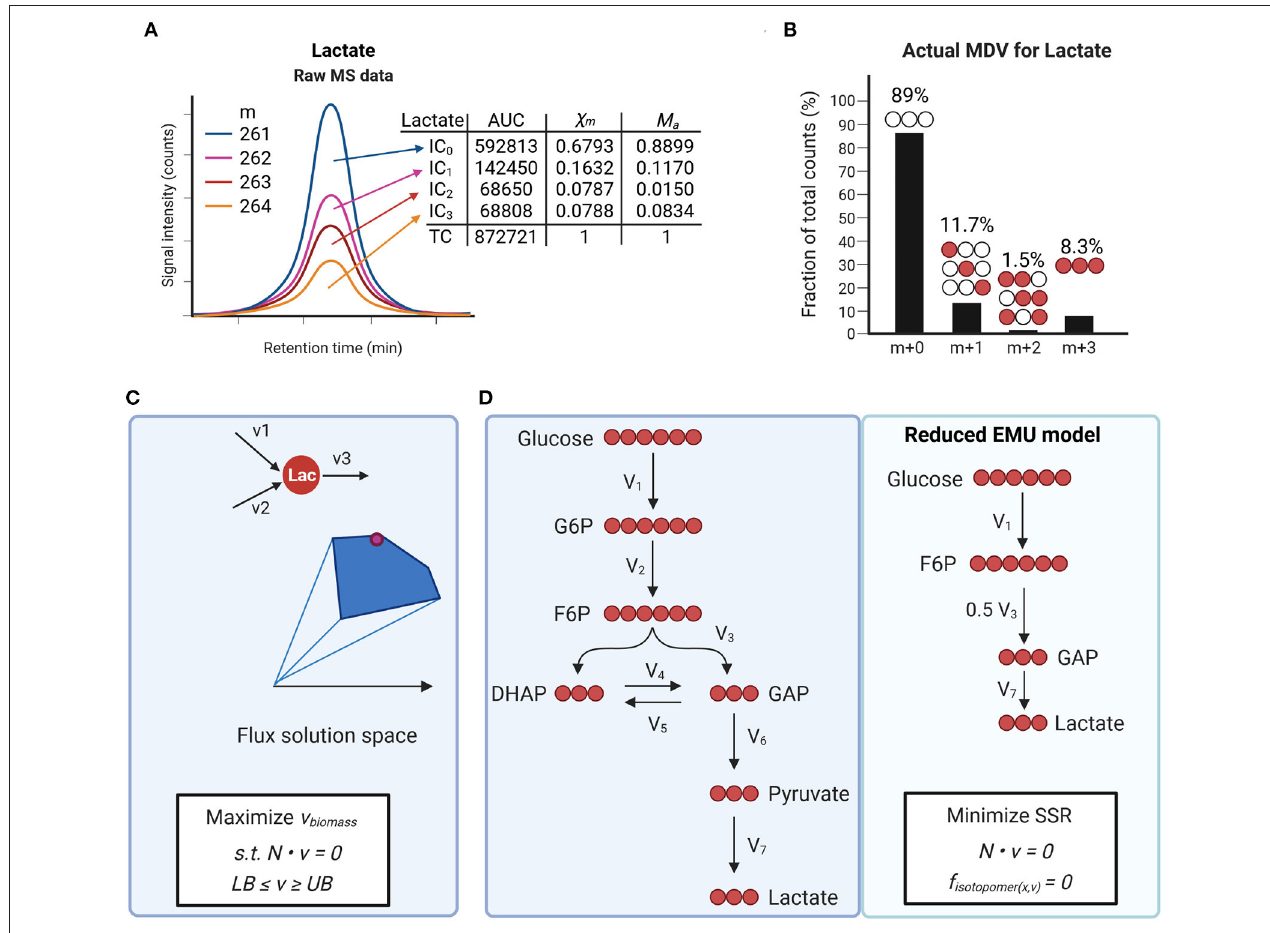
FIGURE 3 | Isotope tracing to measure metabolic fluxes. (A,B) Example of isotopomer distribution analysis using mass spectrometry (MS) for 13 C-lactate. Ion counts for different isotopologues (IC) are determined by measuring the area under the curve (AUC). Mass distribution vectors (MDVs) for lactate (X m ) are determined by dividing each IC by the total counts (TC). Measured MDVs are then corrected for naturally occurring isotopes (B) . Actual MDVs for lactate can now be used for further data analysis such as metabolic flux analysis. (C) Flux balance analysis allows estimating flux distributions at steady state. Optimization functions are defined based on biological questions and applied to a network. Constraints for each flux vector are defined as lower bonds (LB) and upper bonds (UB) which allow to define flux solution spaces. (D) Schematic of carbon atom distribution in a simplified model of glycolysis using [U- 13 C]-glucose infusion. Network reactions can be further reduced to a define a final reduced EMU model. Flux distributions are estimated by minimizing the sum of least-squared residuals (SSR) between the measured rates and model predicted rates subject to stoichiometric